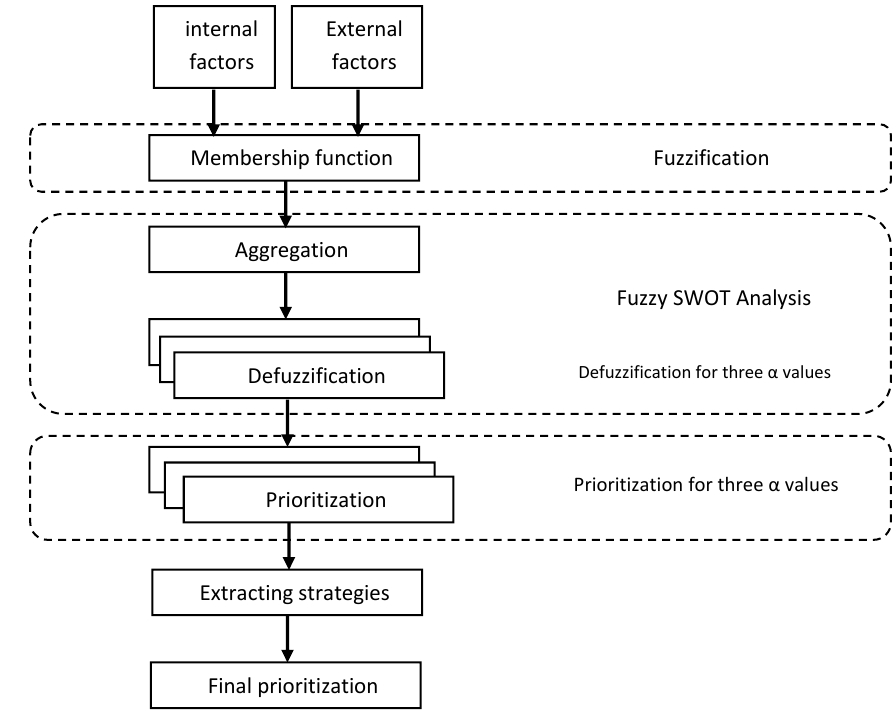
Figure 2. Scheme of algorithm.